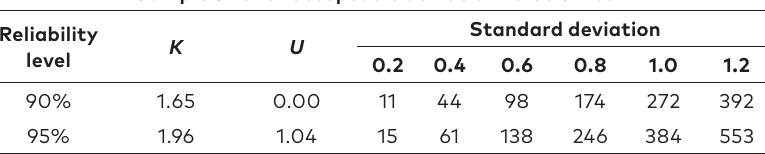
Table 3. Required sample